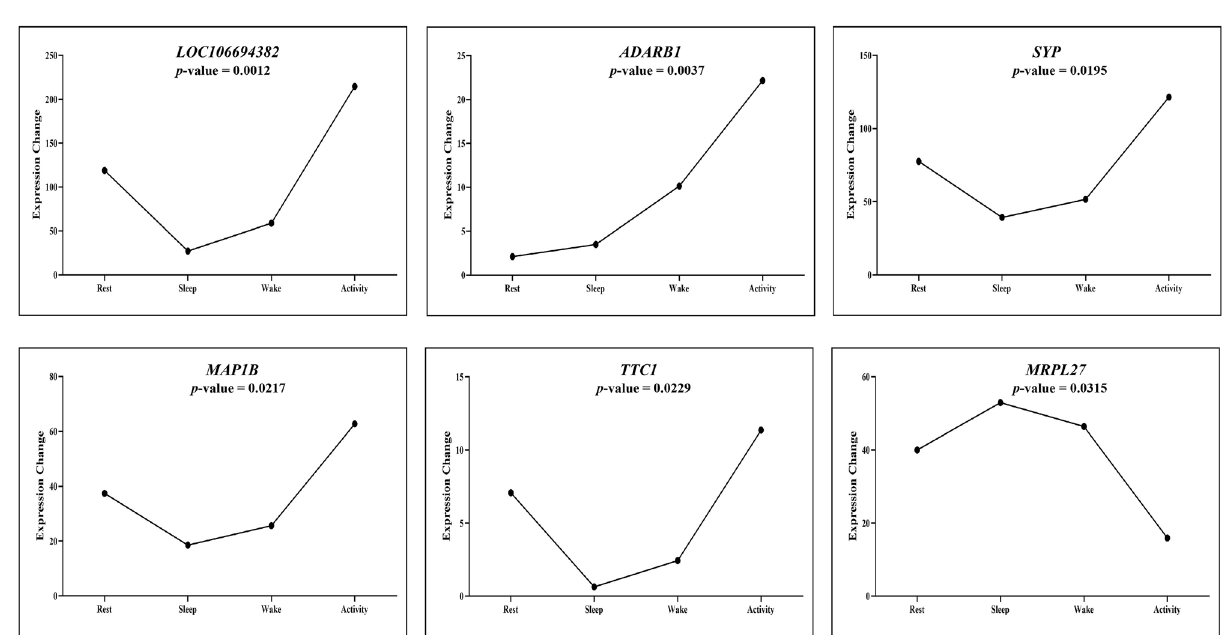
Figure 6. Expression patterns of the six rhythmic genes over the four time points of a